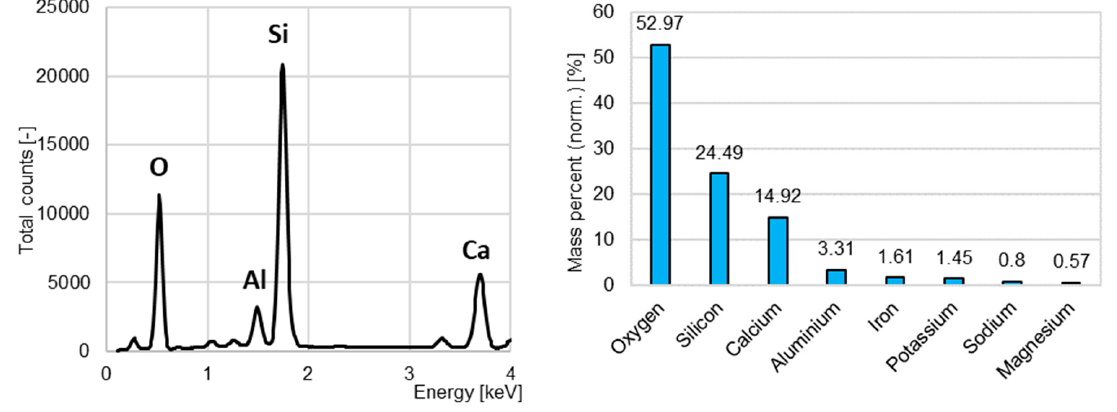
Figure 4. The energy-dispersive X-ray spectroscopy results for the concrete recycling aggregate.